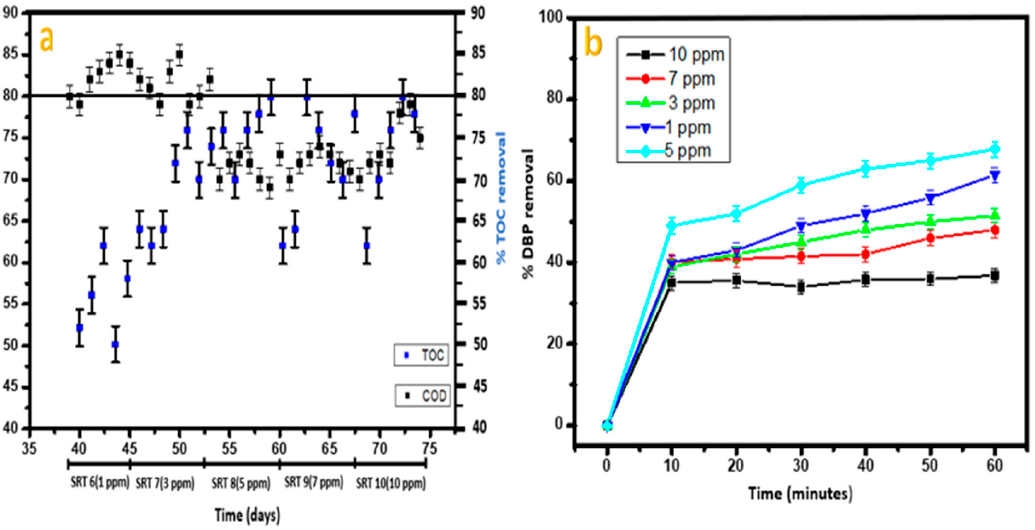
Figure 6. ( a ) Biological percentage removal of COD and TOC towards DBP removal. ( b ) The removal efficiency by microbes monitored on UV-Vis spectrophotometer.